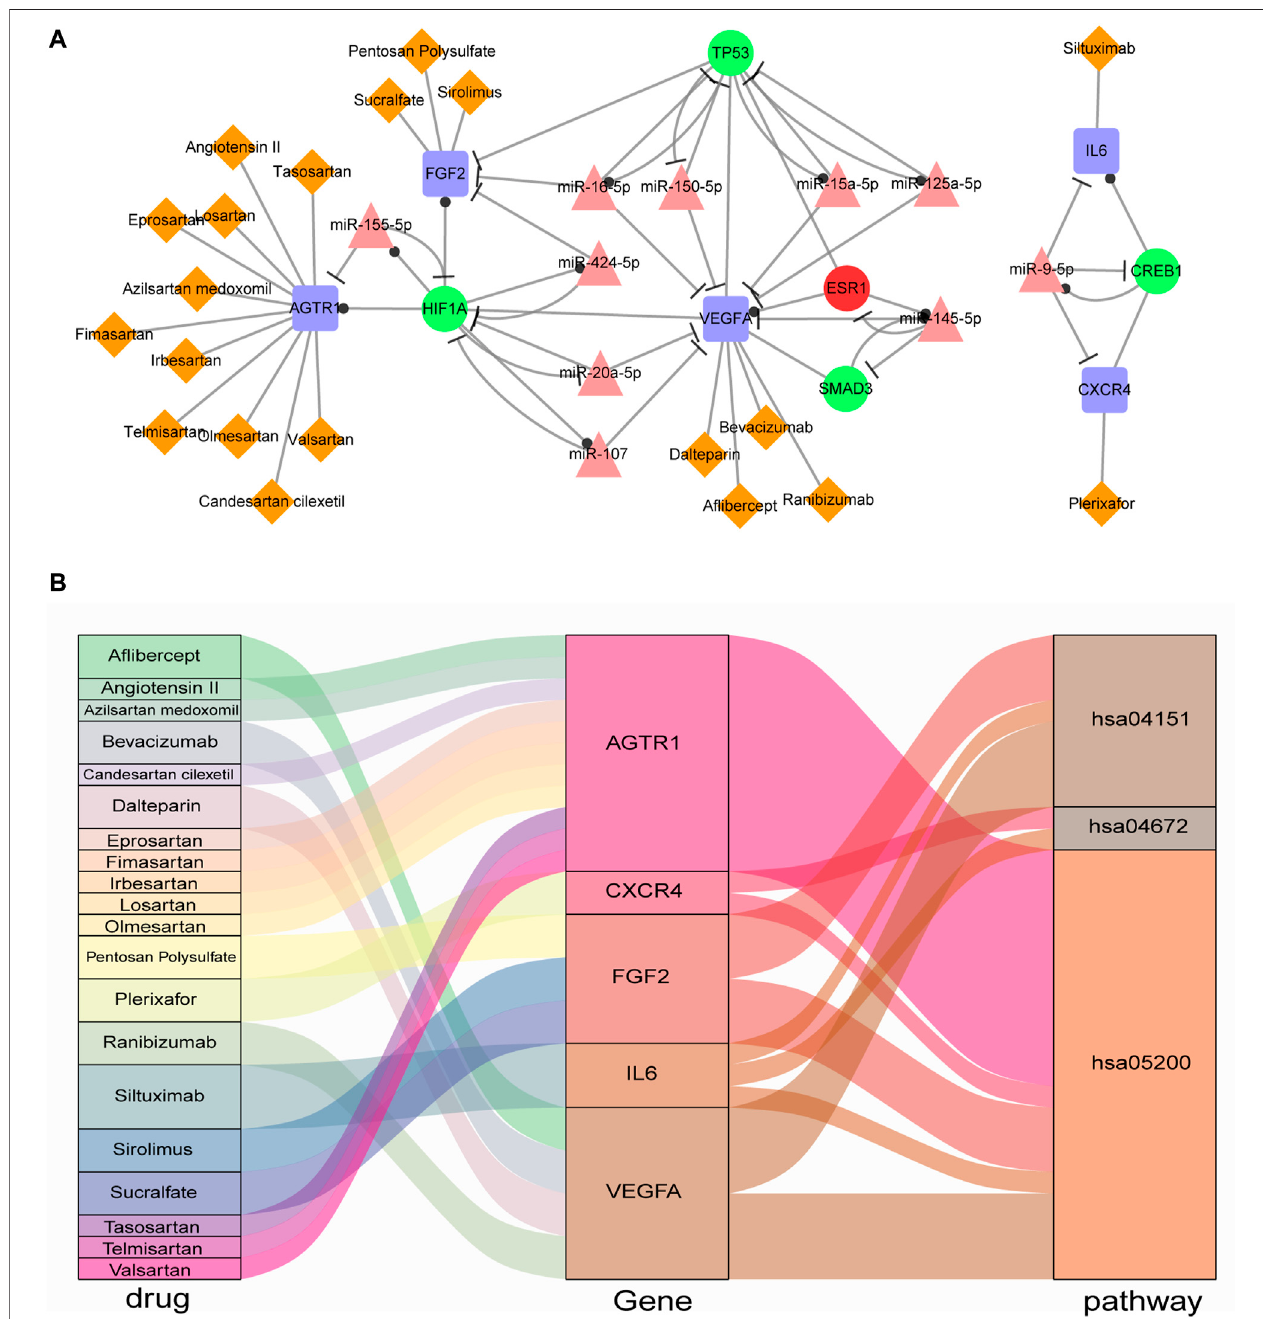
FIGURE6| DrugsscreenedfromIA-CFMSN. (A) AnetworkofselecteddrugstargetedwithscreenedimmunegenesandtheirFFLs. (B) ASankeydiagramofdrug- gene-pathway relationships screened from